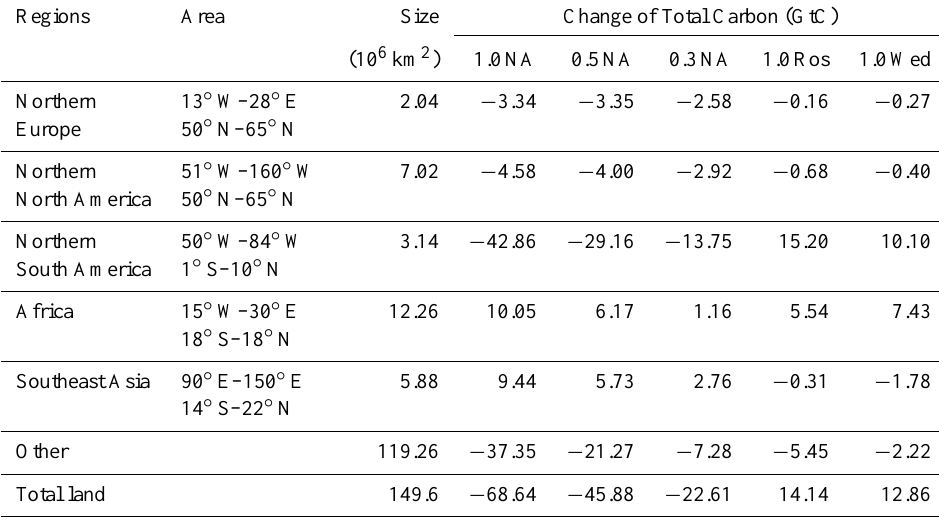
Table 2. A selection of regions that have recorded considerable changes given with their land area, the limits defined and the change of total carbon stocks in that area by the year 101 (end of the perturbation). 0.5NA and 0.3NA experiments are also included in the list for the purpose of comparison.